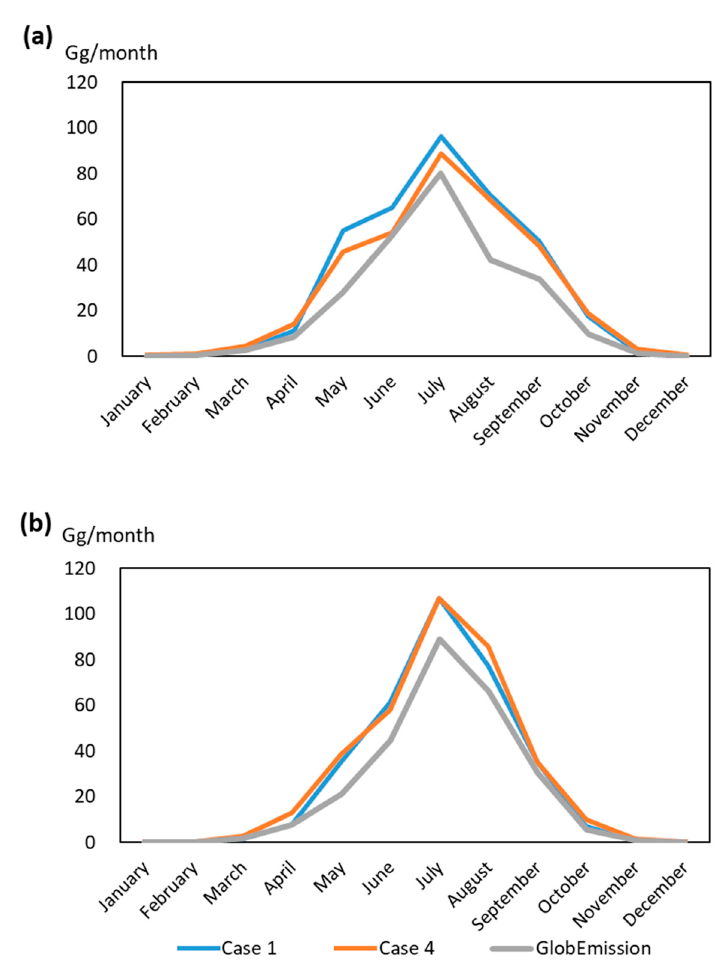
Figure 10. Monthly variations in modeling (bottom-up) isoprene emissions and GlobEmission (inverse) emissions in 2014: ( a ) South Korea; ( b ) North Korea.